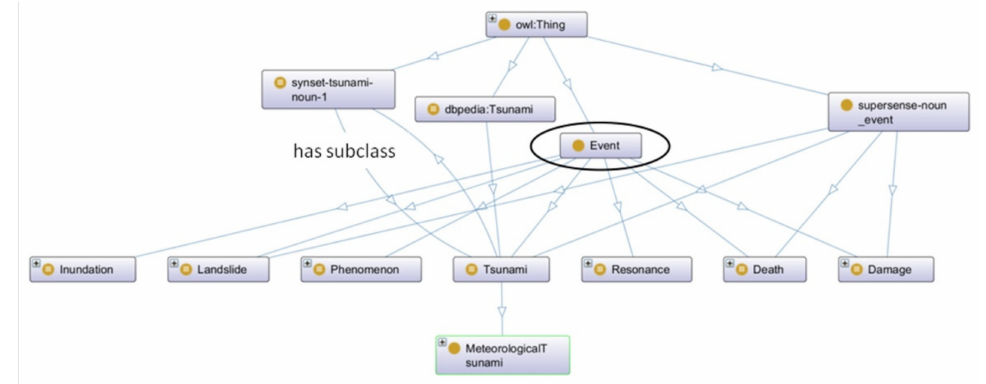
Figure 5. Fragment of the generated ontology (Event in the